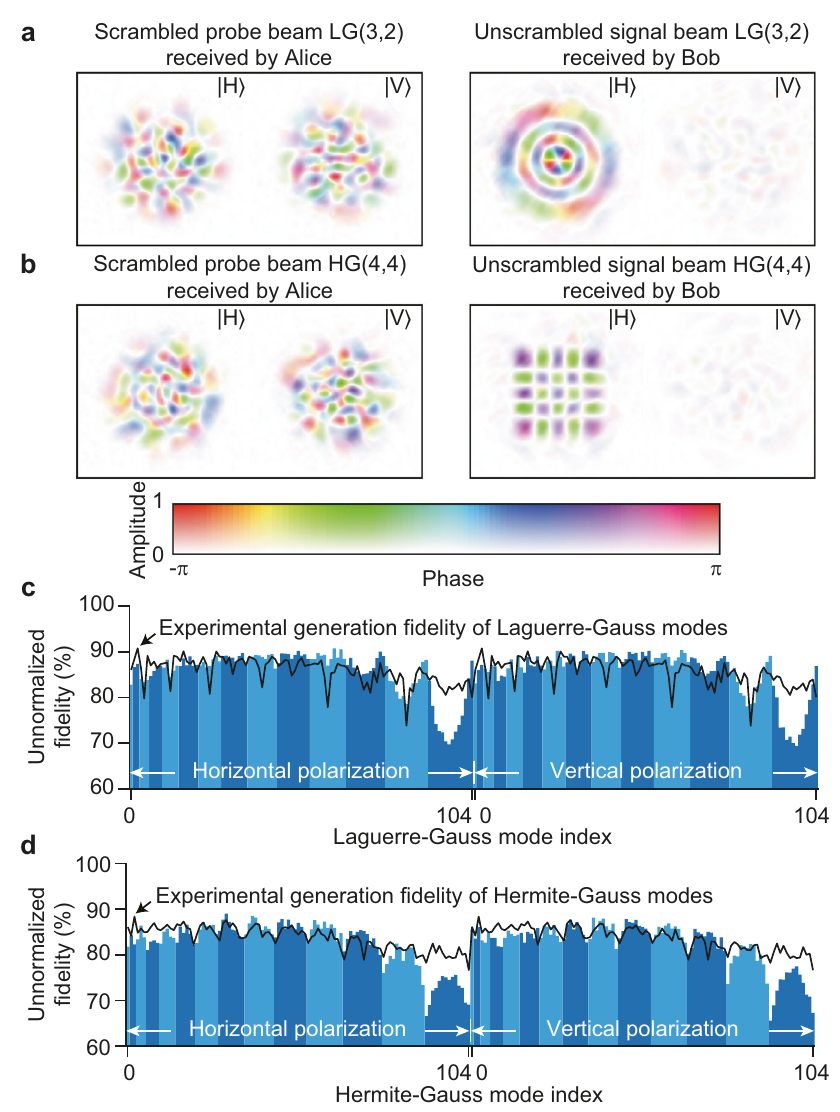
Fig. 2 Modal fi delity measurement. a , b The measured amplitude, phase, and polarization of the scrambled probe beams and unscrambled signal beams for horizontally polarized LG(3,2) and HG(4,4) mode respectively. c , d The unnormalized modal fi delity for unscrambled Laguerre – Gauss modes and Hermite – Gauss modes. A single index is used to denote the two-mode indices for simplicity (see Supplementary Note 3), and the light and dark blue bands denote the odd and even mode group number